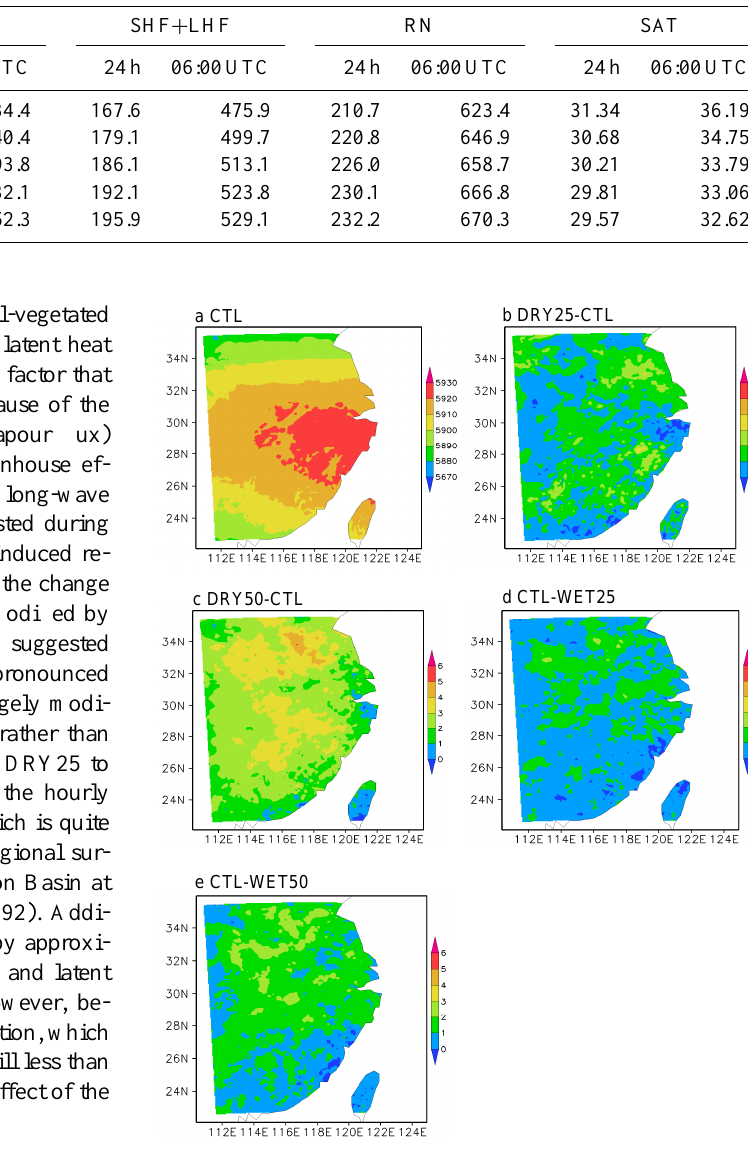
Figure 11. The 10-day mean 06:00UTC 500hPa geopotential height fields and the soil moisture-induced differences in the five groups of simulations (unit: